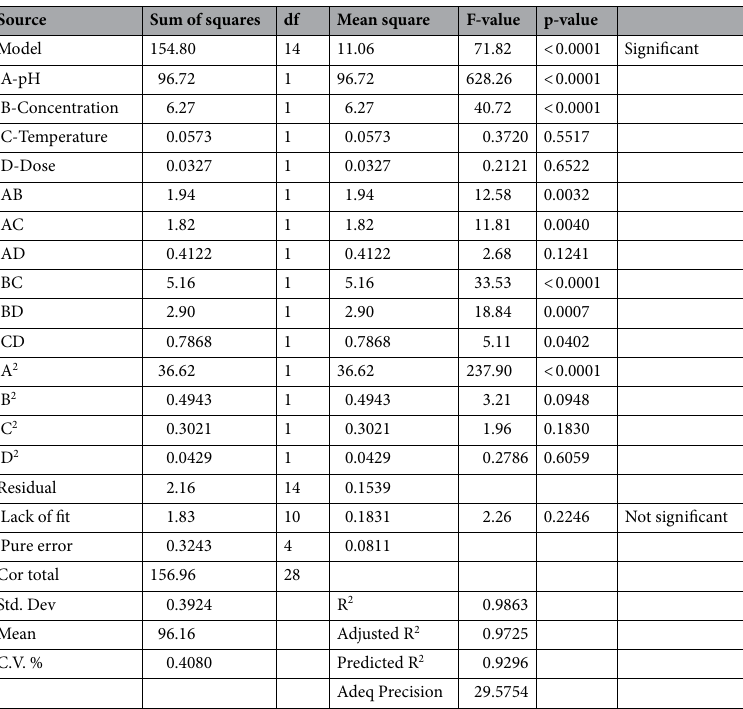
Table 3. Analysis of variance (ANOVA), results for decolourization of MG by nano bentonite.